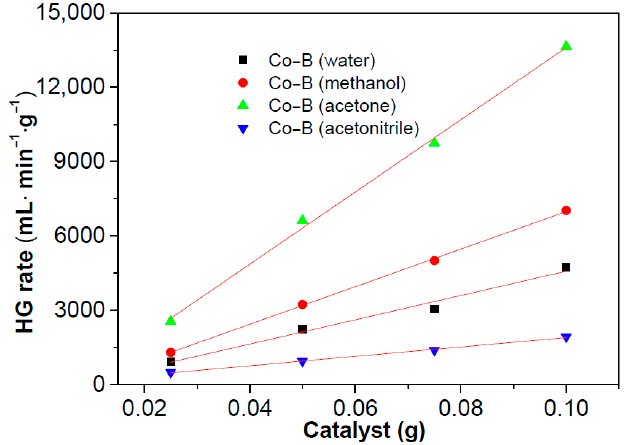
Figure 9. HG rate versus the amount of Co–B catalyst.